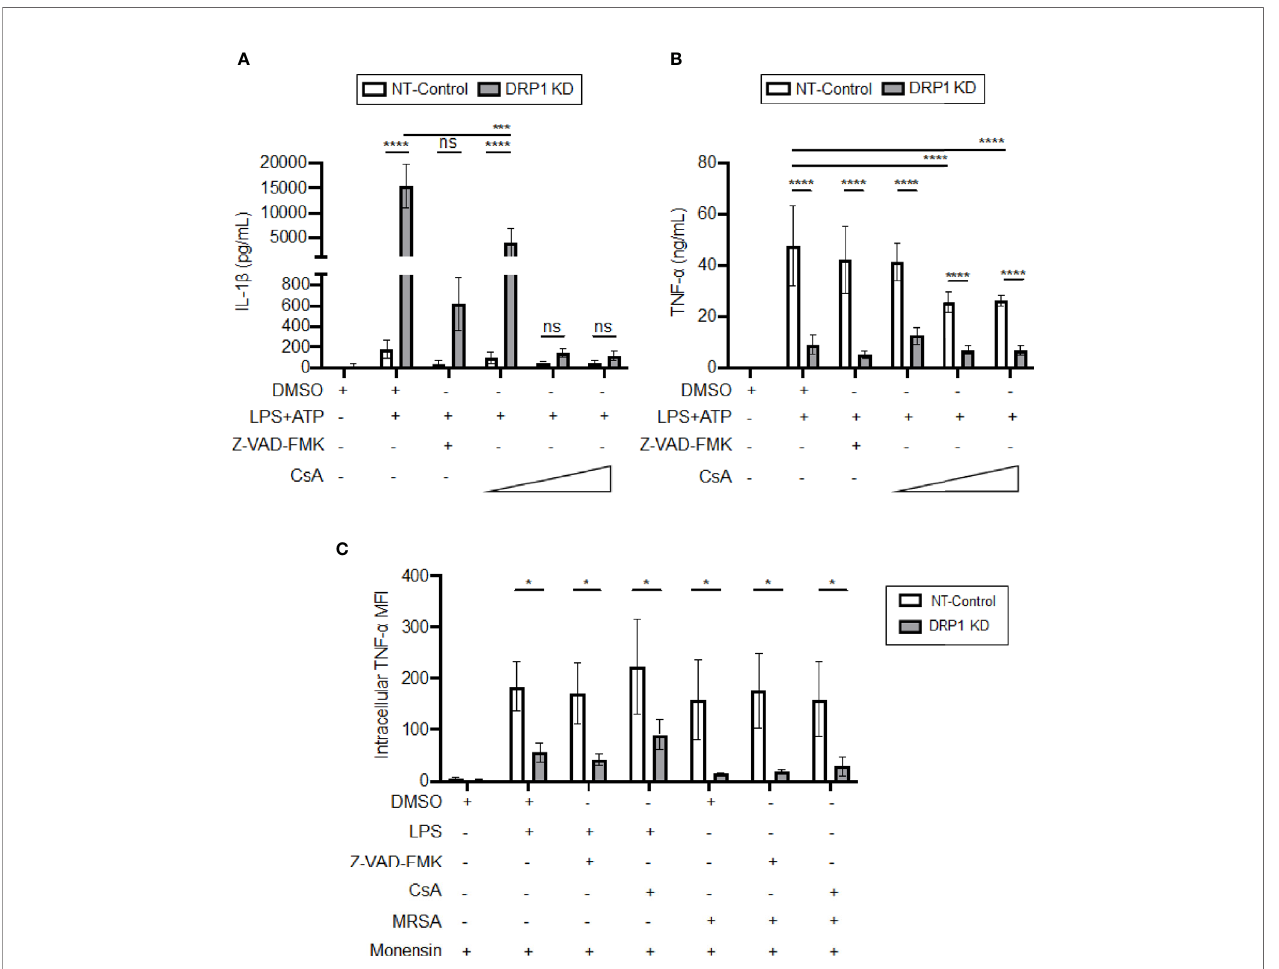
FIGURE 5 | CsA blocks IL-1 b production in DRP1 KD macrophages but inhibits TNF- a production by DRP1 independent mechanism. (A) Quanti fi cation of IL-1 b (A) and TNF- a (B) levels in culture media of NT-Control and DRP1 KD macrophages after stimulation with LPS+ATP for 8h in the presence and absence of Z-VAD- FMK or various concentrations of CsA. (C) MFI of TNF- a intracellular staining of NT-Control and DRP1 KD macrophages was assessed by fl ow cytometry. Macrophages were treated with the indicated inhibitors and stimulated with LPS (200 ng/ml), infected with MRSA (MOI 20) or left untreated (Mock) for 4h. Data were analyzed with FlowJo software where MFI represents geometric mean. Graphs are presented as the mean of n ≥ 3 independent experiments ± SD. Two-way ANOVA with Sidak ’ s multiple comparisons post-test was used to determine statistical signi fi cance. * P < 0.05; *** P < 0.001; **** P < 0.0001. ns: not signi fi